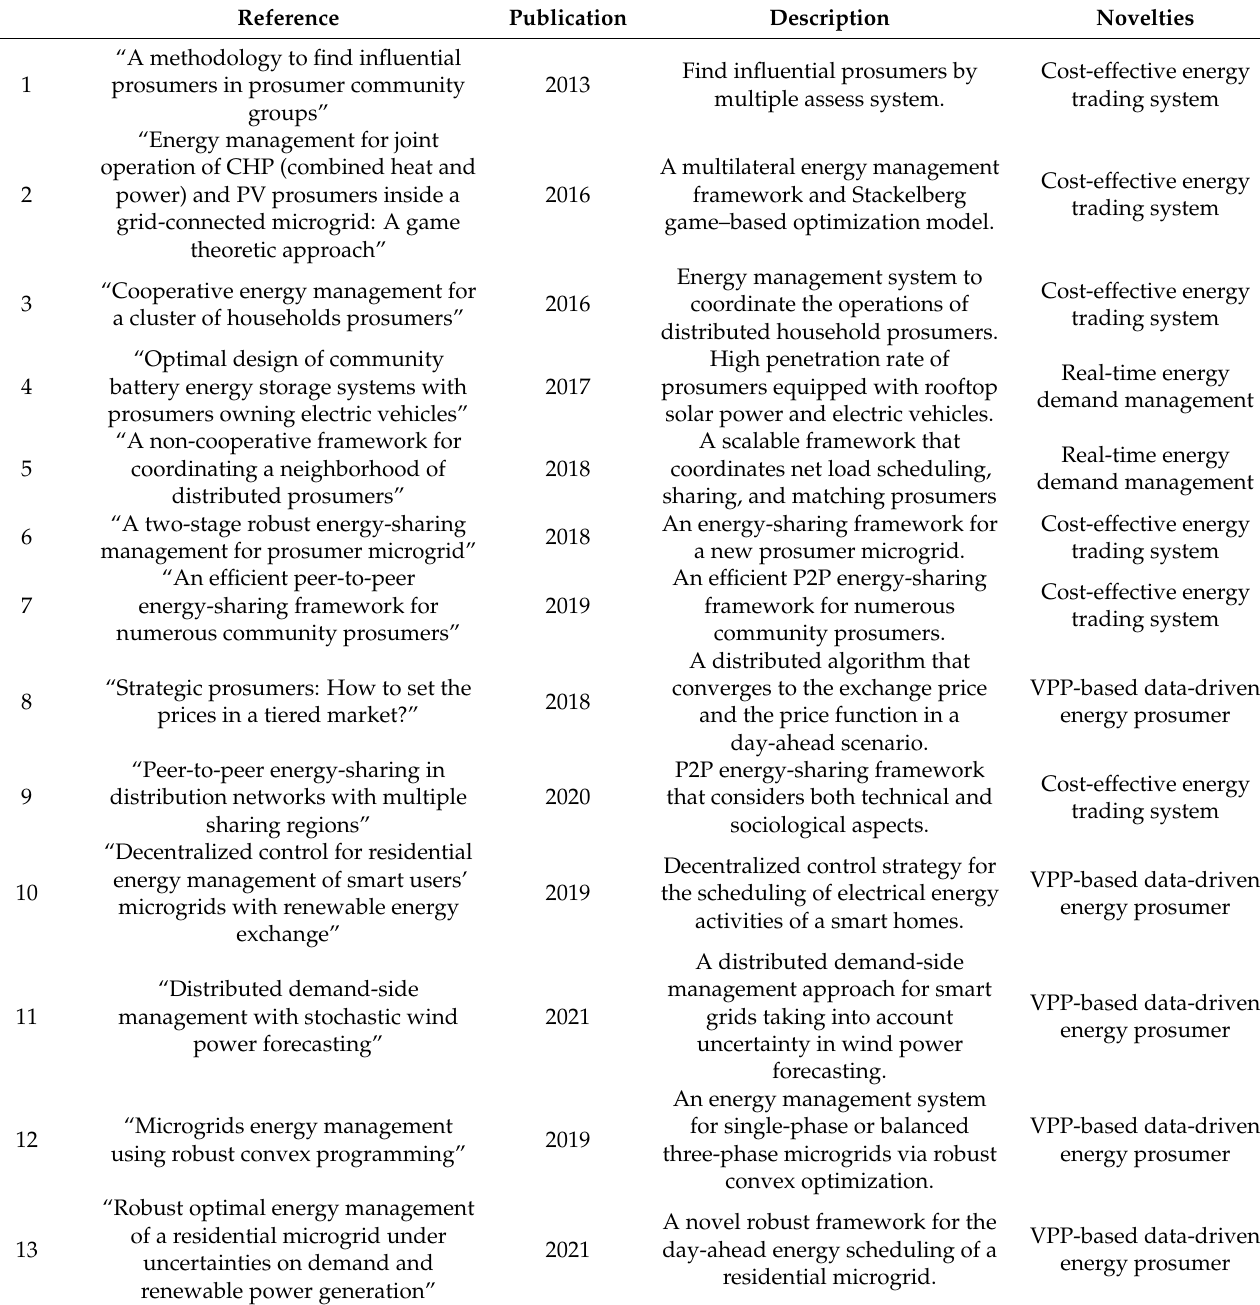
Table 1. Analysis of novelties of the proposed paper compared with existing